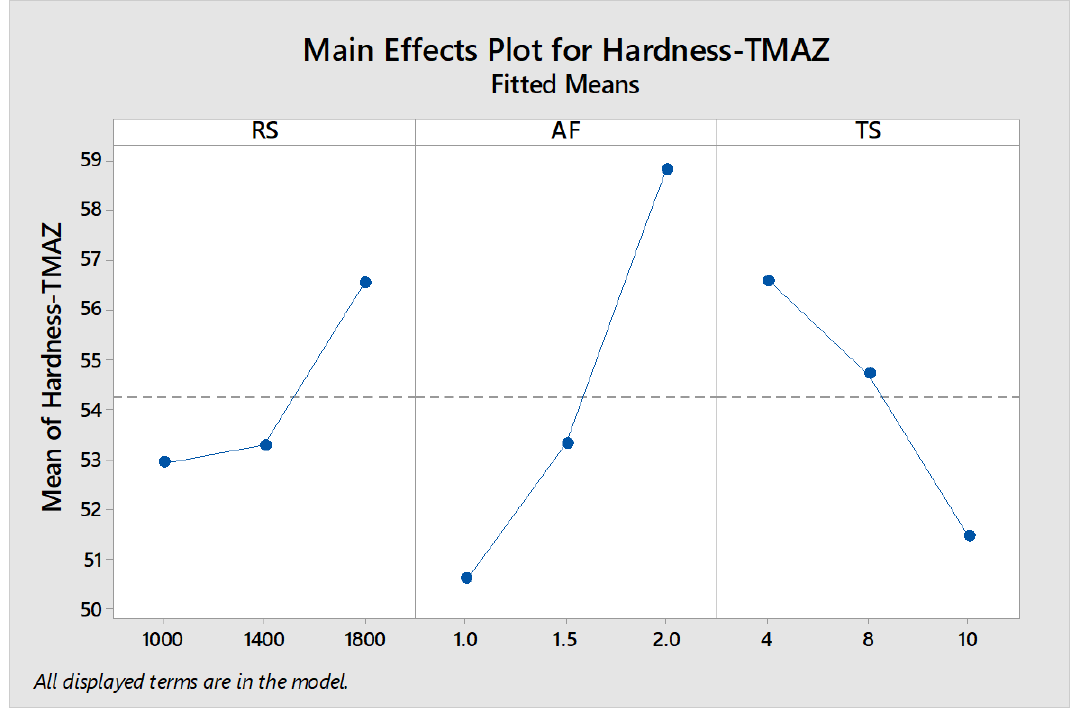
Figure 17. Main effects plot — hardness in TMAZ.